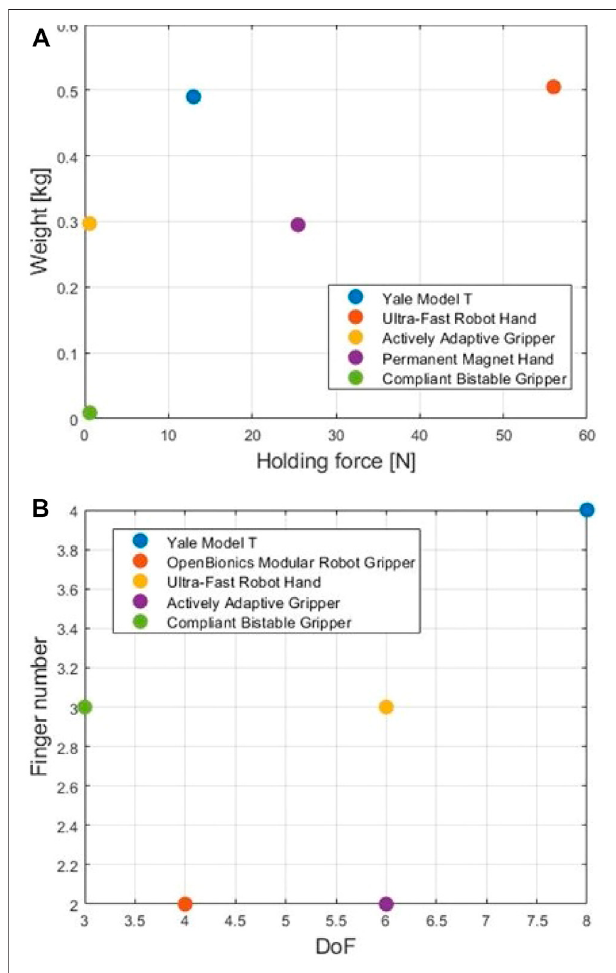
FIGURE 4 | A comparison of the payload capacity and dexterity of the reviewed aerial grippers. Sub fi gure (A) shows acomparison ofthe weightand holdingforceoftheexaminedaerialroboticgrippers,while (B) demonstratesa comparison of the number of fi ngers and DoF.